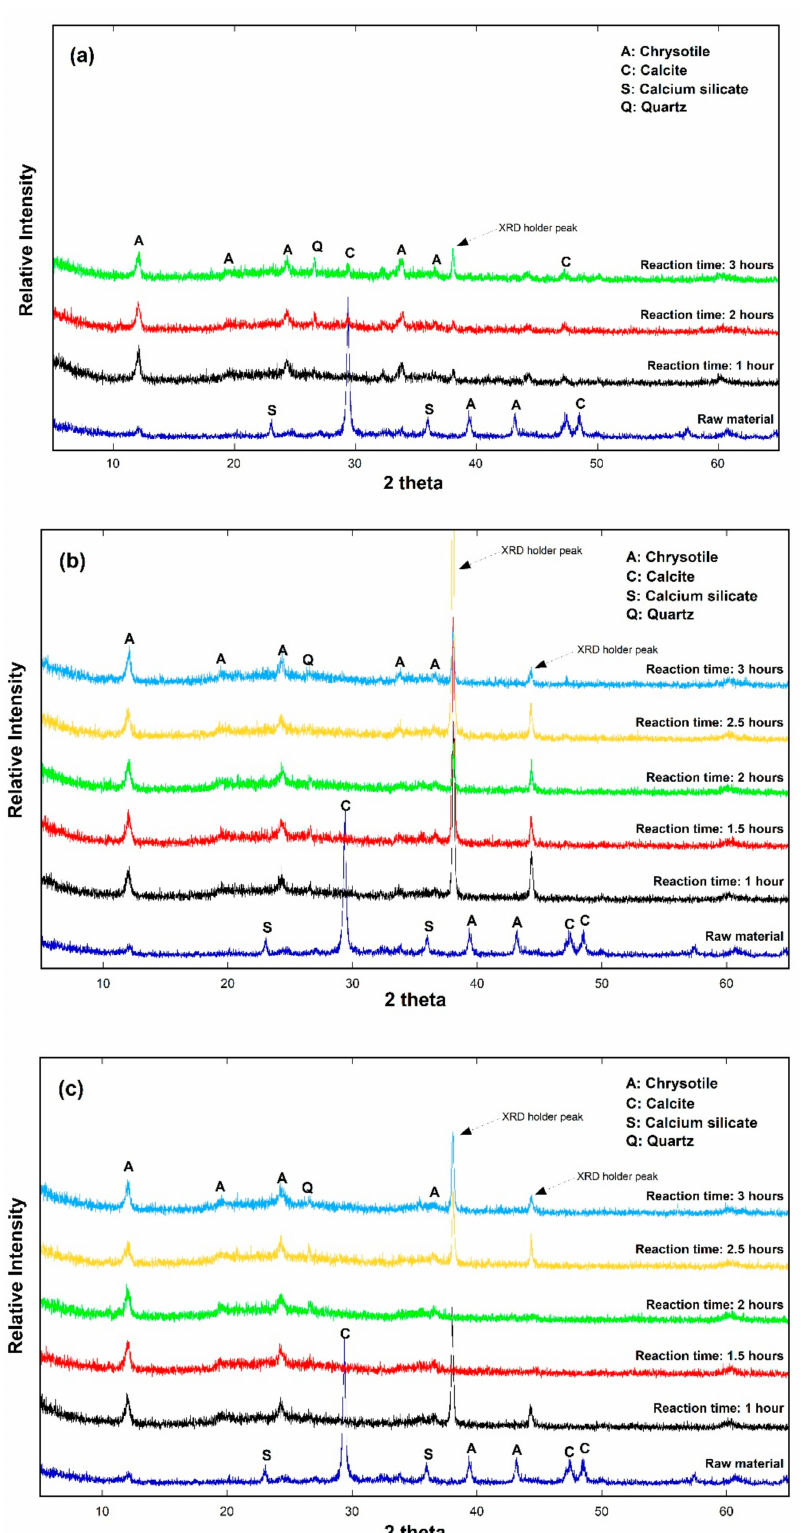
Figure 5. XRD results of solid samples obtained from cement hydrate removal tests (peaks at 39 and 44 are specimen holder). ( a ) HCl to solid ratio 0.400 g/g ( b ) HCl to solid ratio 0.440 g/g, and ( c ) HCl to solid ratio 0.456